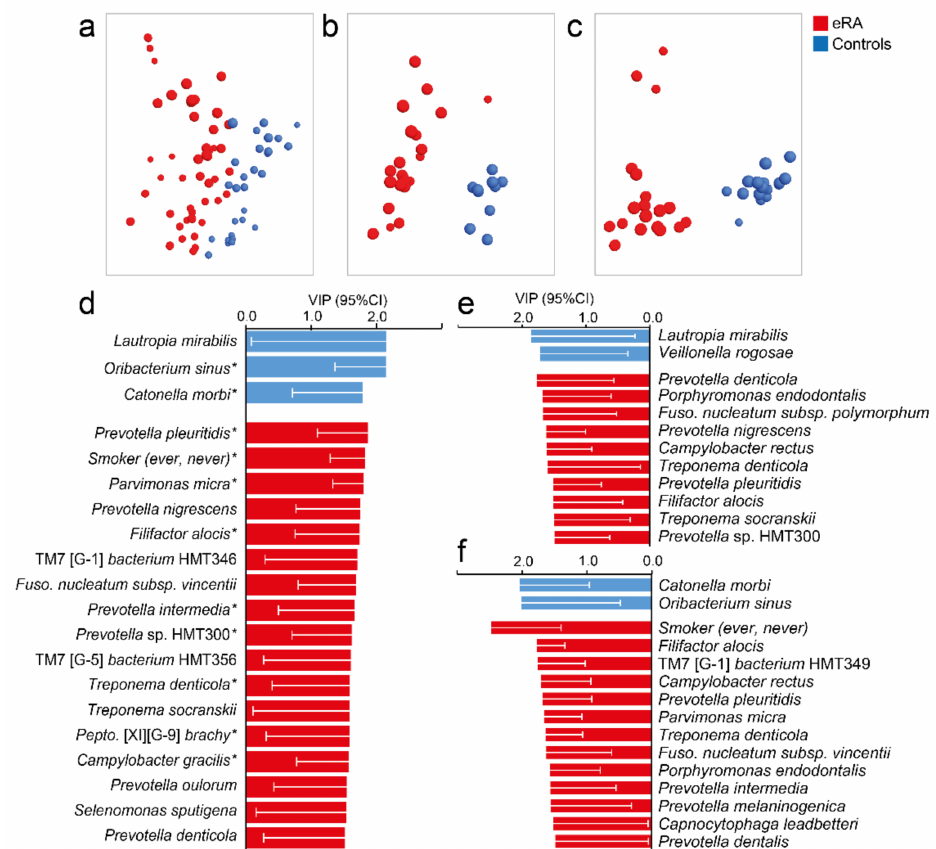
Figure 4. Saliva microbiota pattern by periodontal status in early onset RA versus healthy subjects. ( a – c ) Loading plots from OPLS-DA modelling in ( a ) all participants for whom dental data could be obtained, ( b ) in eRA subjects and healthy controls with no sign of periodontal disease, and ( c ) in e RA subjects and healthy controls with PPD of ≥ 6 mm. ( d – f ) Bar graphs showing bacterial species and additional variables influential in the model projections in ( d – f ). Data are expressed as Variable In Projection (VIP) values with 95% confidence interval, for ( d ) eRA patients and healthy controls with dental data, ( e ) eRA patients and healthy controls with no sign of periodontal disease and ( f ) eRA patients and healthy controls with a sign of periodontal disease. Red colour represents eRA and blue represents healthy controls. For a full list of VIP values, see Table S4. A star (*) by the species indicates that it was detected as influential in the